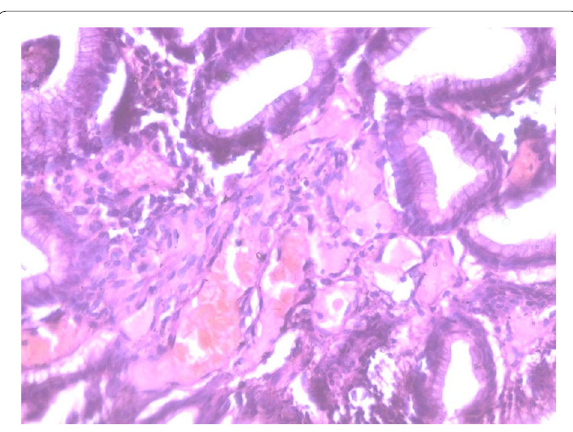
Fig. 2 Gastric antral biopsy showing signs of GAVE; fibrosis of the lamina propria with fibrin thrombi in the small vessels (H & E,